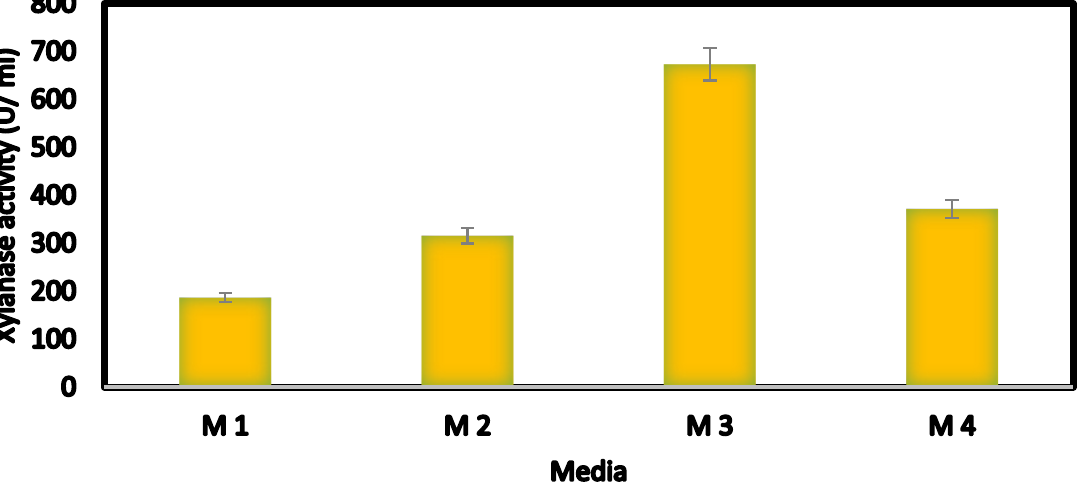
Figure 3. Effect of different culture media on xylanase productivity by Trichodermaharzianum kj831197.1.NB:M1: basal medium, M2: Paul et al. (1999), M3: Mandels and Sternburg (1976), and M4: Haltrich et al. (1994).